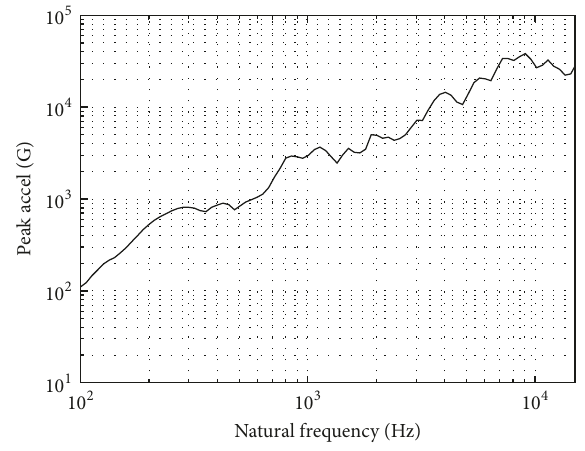
Figure 7: Typical shock response spectrum of shear type explosive